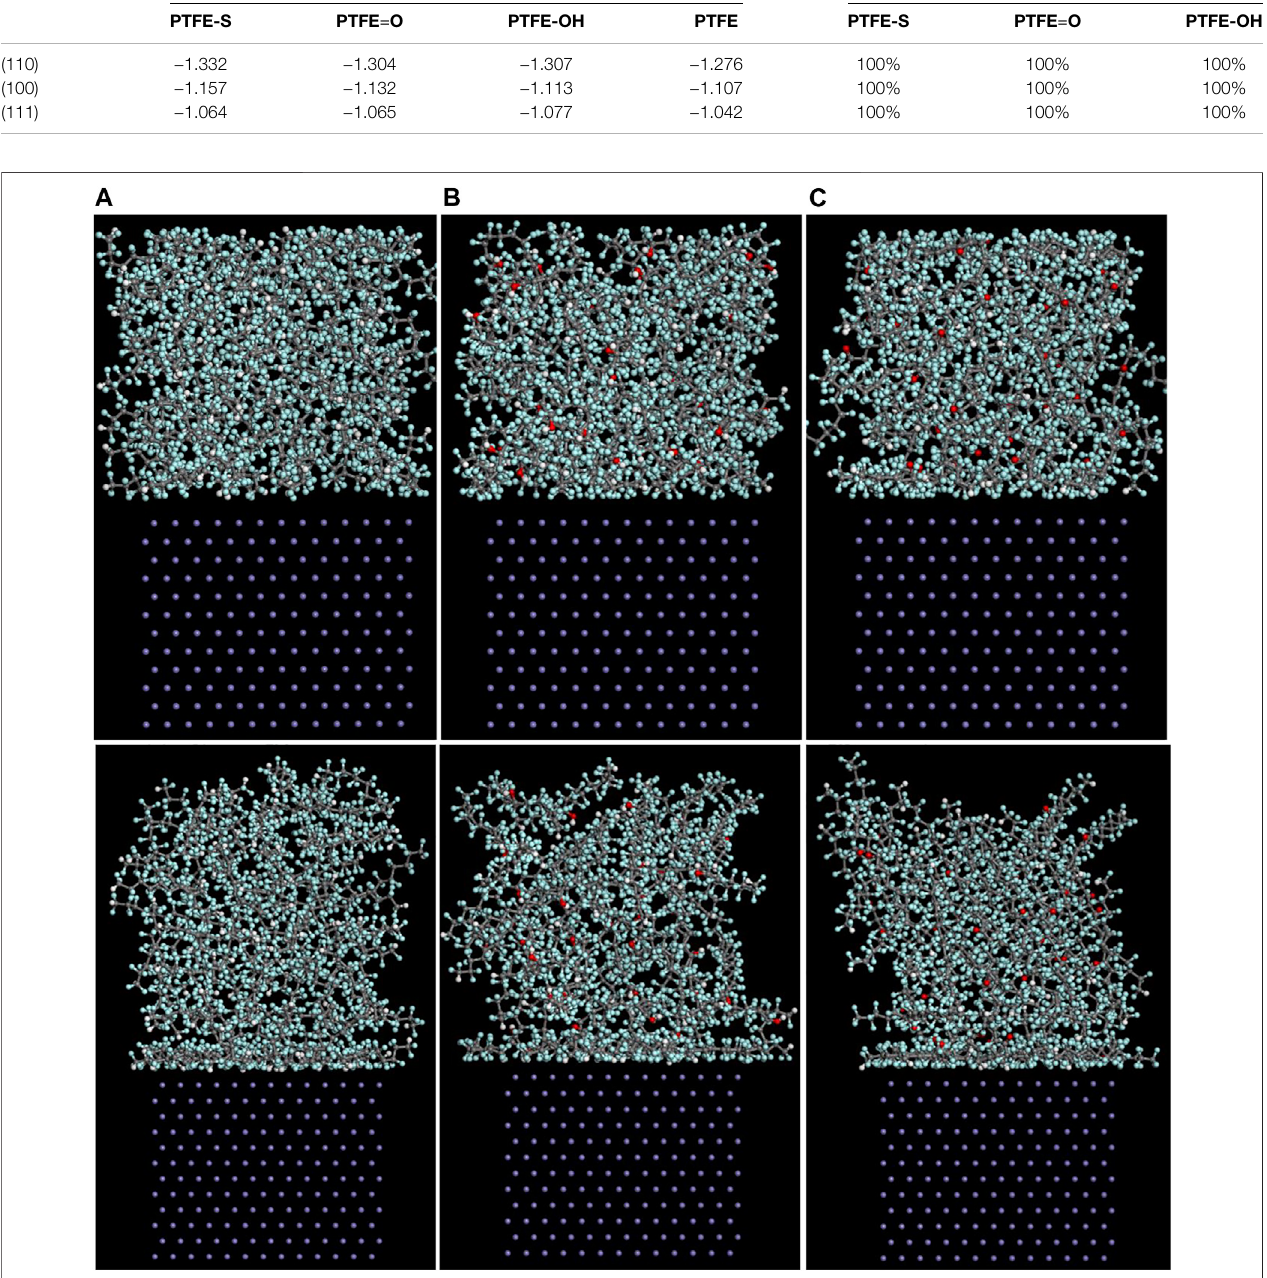
FIGURE 6 | Side views of the (A) (110)/PTFE-S, (B) (110)/PTFE-OH, and (C) (111)/PTFE (cid:2) O interface systems before (above) and after (below) the molecular dynamics.